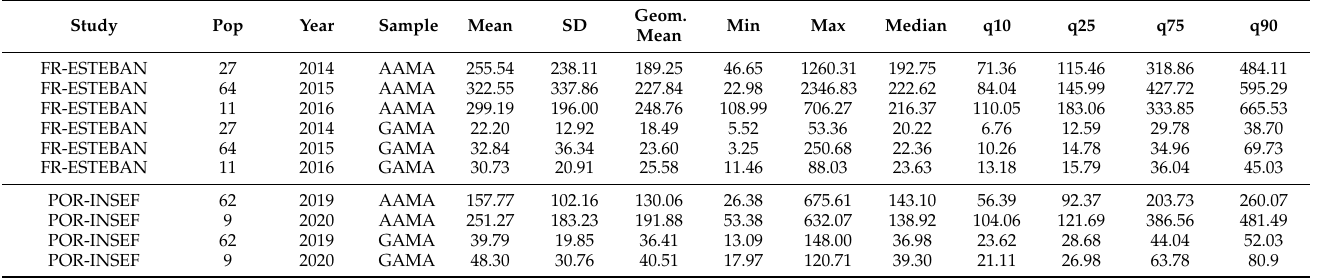
Table A9. Descriptive statistics of acrylamide biomarker levels per study and year (adults,